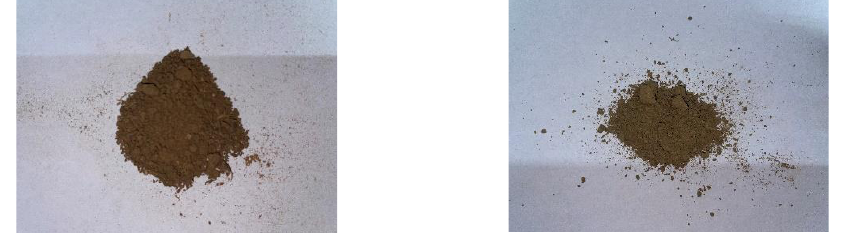
Figure 2. Macro photo of soil in Baoqizhai Village ( left ). Macro photo of soil in Dayangyu Valley ( right ).